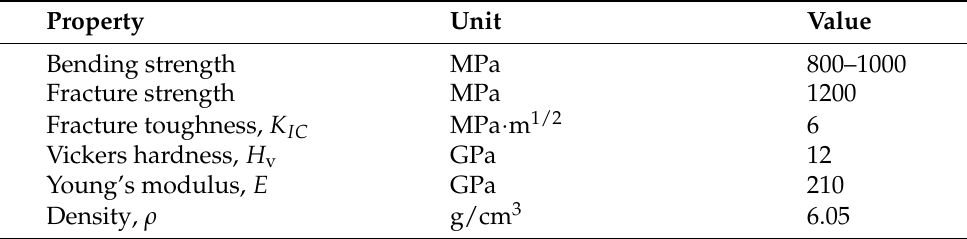
Table 2. Properties of the dental zirconia ceramics used for the